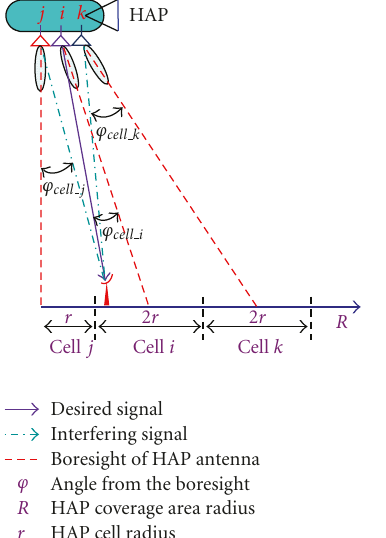
Figure 6: HAP cellular cochannel interference evaluation